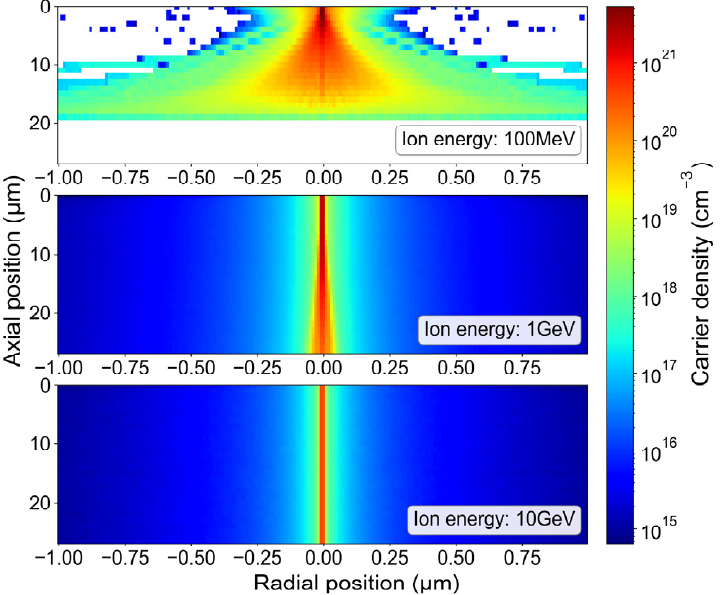
Figure 7. The 2-D profile of EHPs’ distribution when Fe ion strike in silicon. (Note: the ion energies are 100 MeV, 1 GeV and 10 GeV, respectively.)